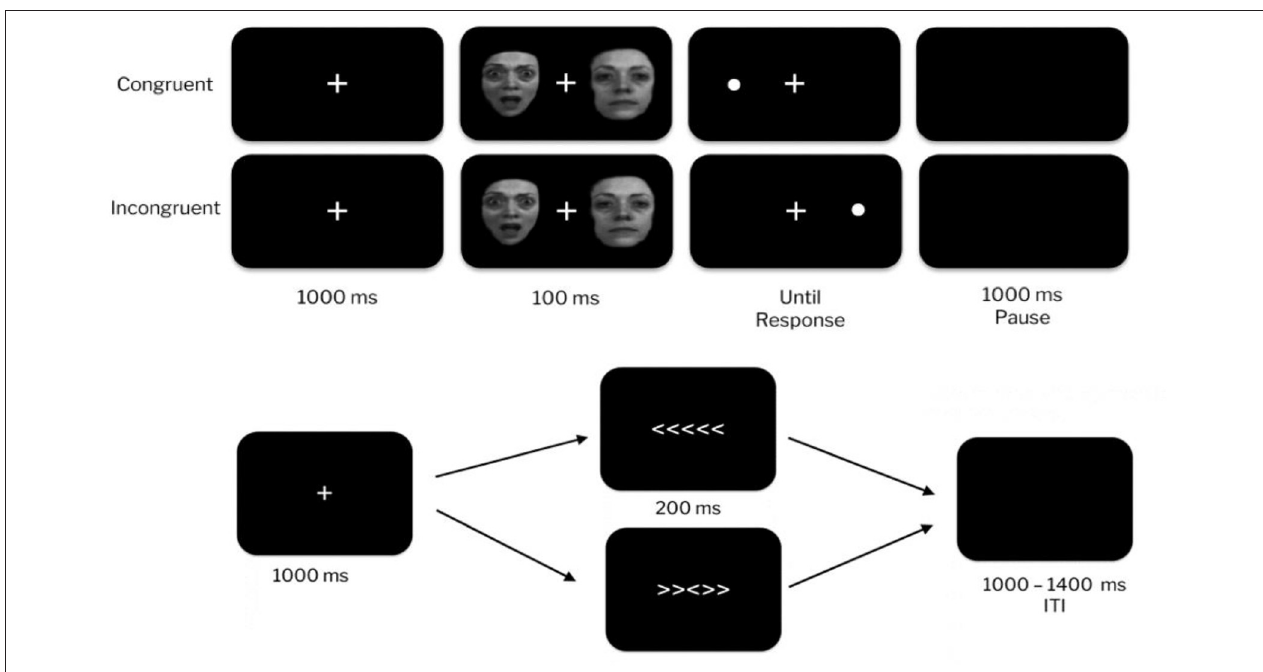
FIGURE 1 | Dot-probe task (top). Examples of congruent and incongruent trials with fearful and neutral face stimuli. Participants respond to the location of the target dot. Attentional bias is measured by faster reaction times on congruent relative to incongruent trials. Arrow flanker task (bottom). Participants were instructed to identify the direction of the center arrow when flanker arrows were compatible (top) or incompatible